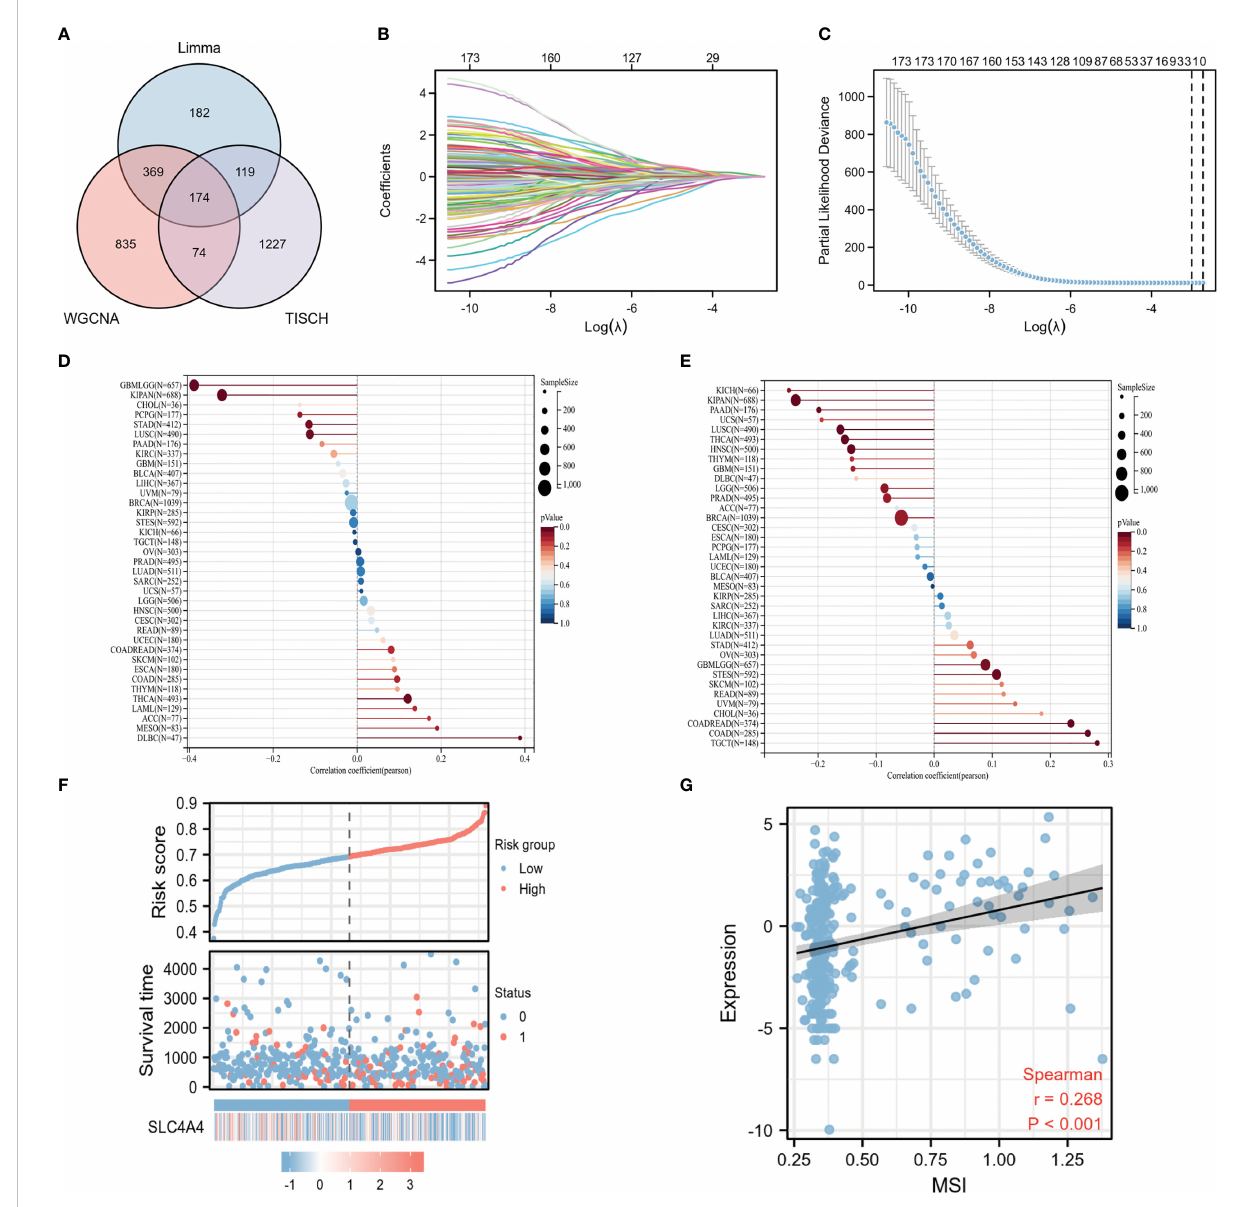
FIGURE 5 The correlation between the potential biomarker SLC4A4 and MSI is signi fi cant. (A) The Venn diagram indicates 174 intersecting genes, (B) the trace diagram of the different variables in the Lasso regression, (C) two undetermined variables were obtained by Lasso regression, (D) lollipop plot of the correlation between TIMP1 expression in different tumors and MSI, (E) the lollipop plot of correlation between SLC4A4 expression in different tumors and MSI, (F) risk factor diagram, and (G) correlation scatter